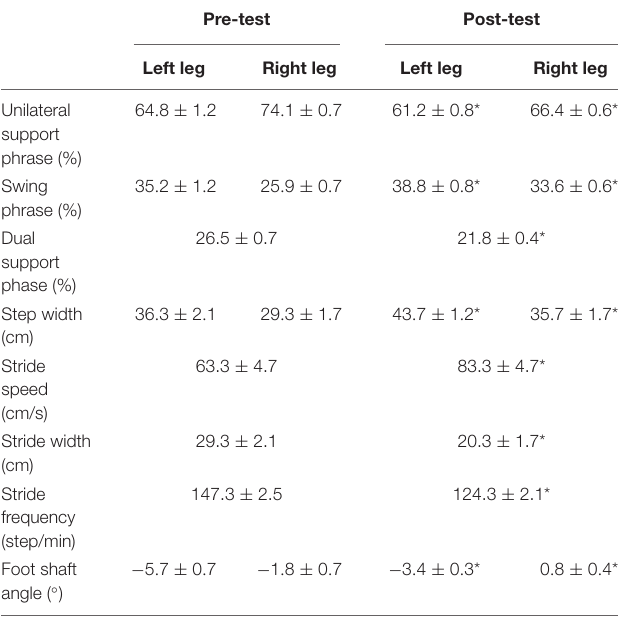
TABLE 4 | Pre-test and post-test of spatial and temporal parameters of gait and foot axis angle. Pre-test